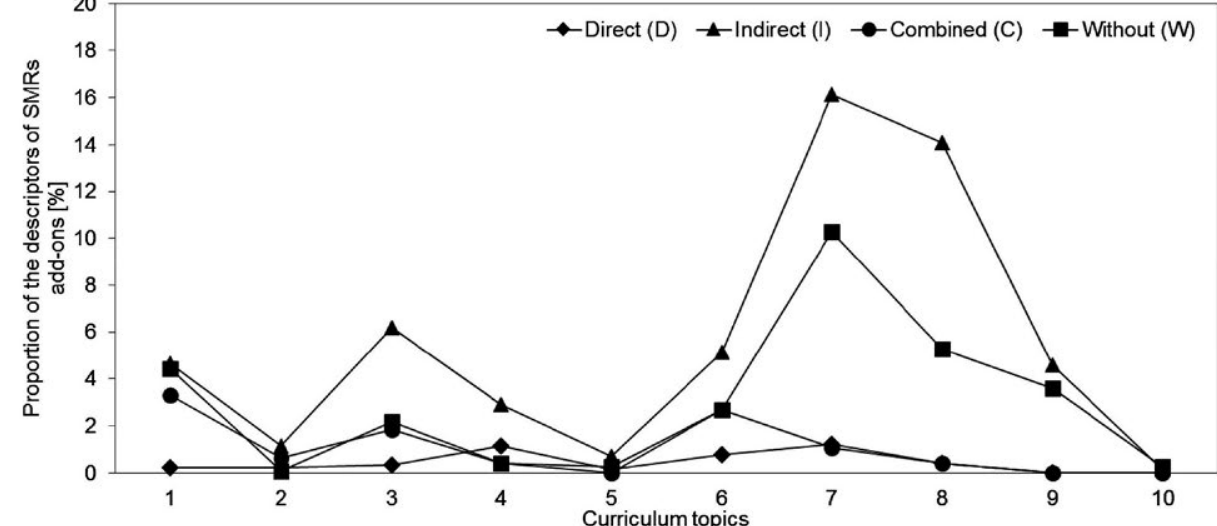
Figure 1. The proportion of SMRs with particular descriptors within all of the topics in the textbook sets [Curriculum topics: Chemistry is a World of Matter (1); Atom and the Periodic System of Elements (2); Compounds and Bonding (3); Chemical Reactions (4); The Elements in the Periodic Table (5); Acids, Bases and Salts (6); Hydrocarbons and Polymers (7); Organic Compounds Containing Oxygen (8); Organic Compounds Contain- ing Nitrogen (9); The Mole